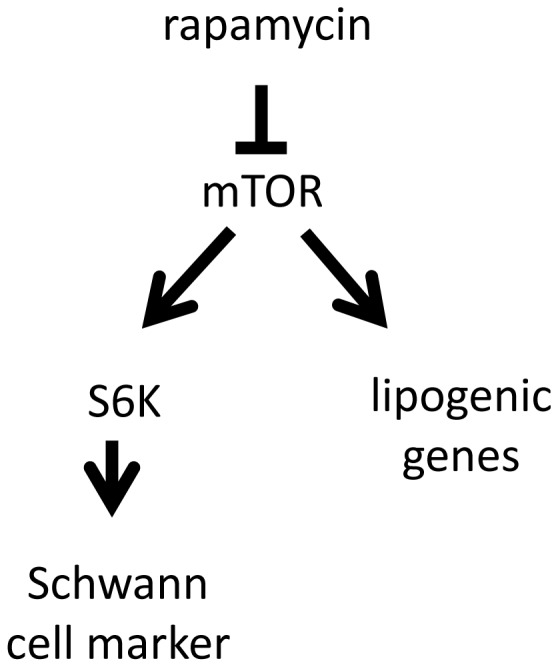
Model of mTORC1 involvement in Schwann cell differentiation.Rapamycin blocks mTORC1 and results in the down regulation of Schwann cell markers (e.g.: S100b) and in the down regulation of lipogenic genes (e.g.: LDLR, HMGCR). Our data indicates that S6K1 regulates the expression of S100b, but not of LDLR and HMGCR.